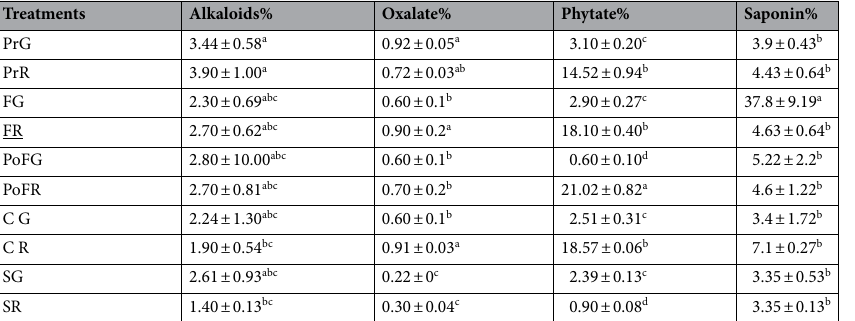
Table 7. Anti-nutrients contents of samples of green and red roselle. Values shown are mean ± SD; different letters along a column represent significant differences at p < 0.05 among all the treatments. PrG pre-flowering green, PrR pre-flowering red, FG flowering green, FR flowering red, PoFG post-flowering green, PoFR post- flowering red, CG calyces green, CR calyces red, SG seed green, SR seed red.